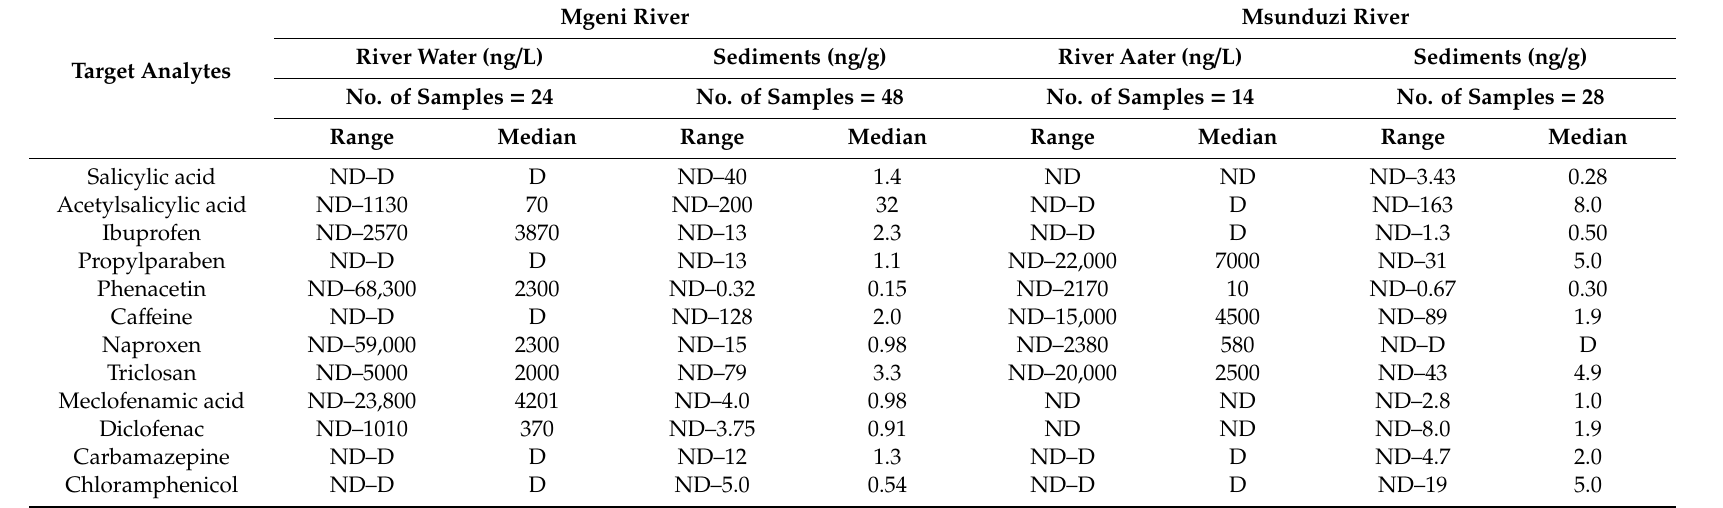
Table 3. Quantification of targeted contaminants in the Mgeni and Msunduzi